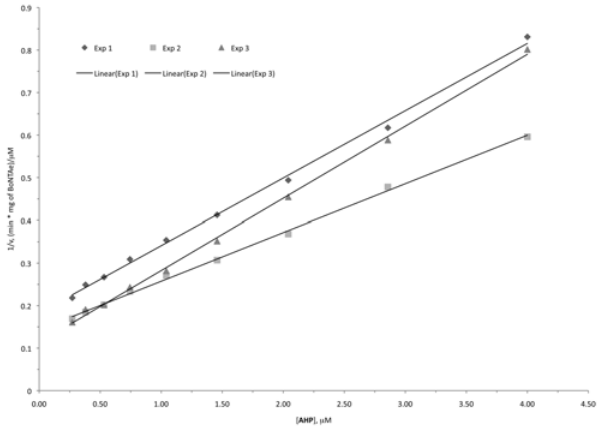
Figure 7. Dixon plots for competitive inhibition of BoNTAe by AHP.